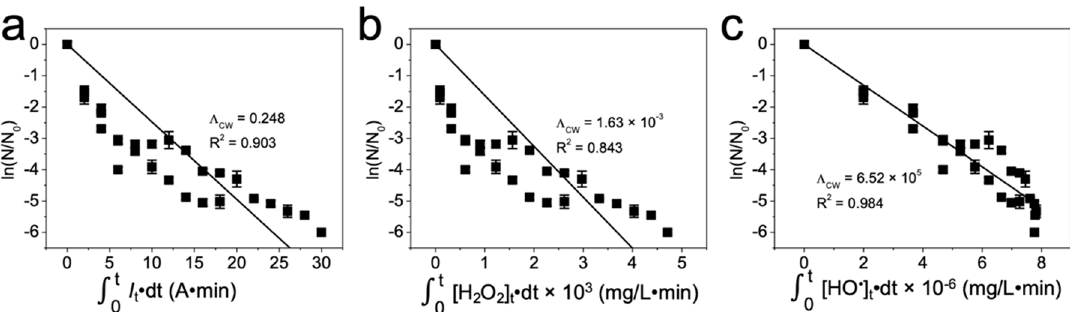
Figure 5. Chick–Watson model fitting with ( a ) electric current, ( b ) generated hydrogen peroxide, and ( c ) produced hydroxyl radical as input disinfectant.